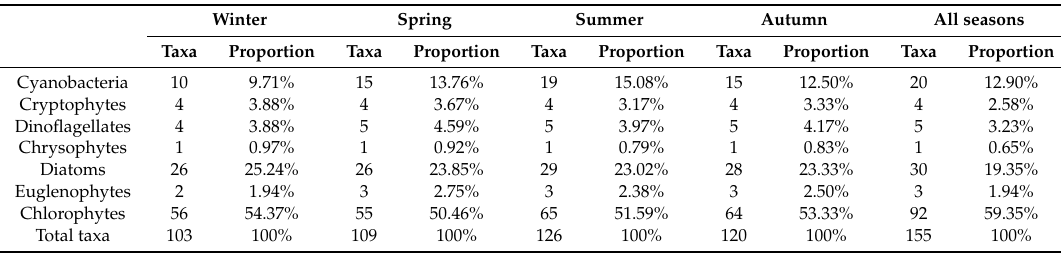
Table 1. Species of phytoplankton and their respective proportion (%) in di ff erent seasons in the Gaozhou